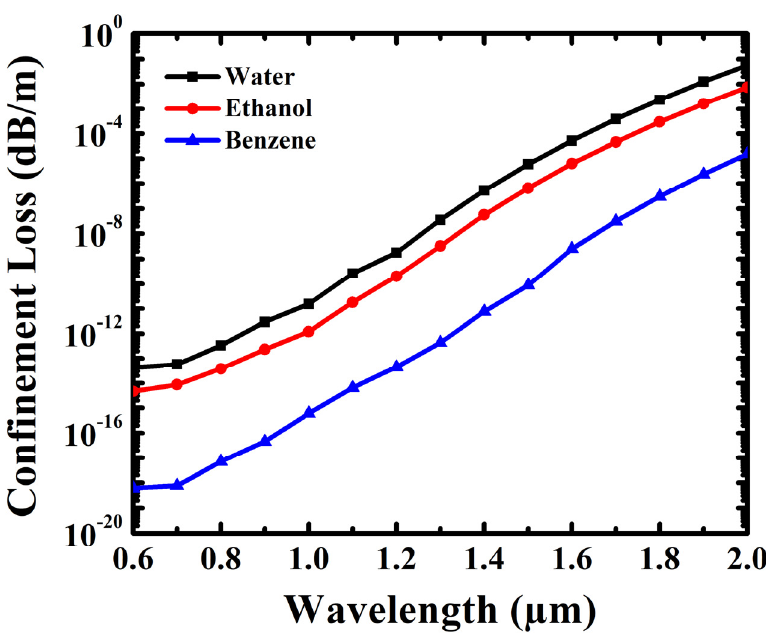
Figure 7. Confinement loss of the PCF sensor with water, ethanol and benzene, for different operating wavelengths.